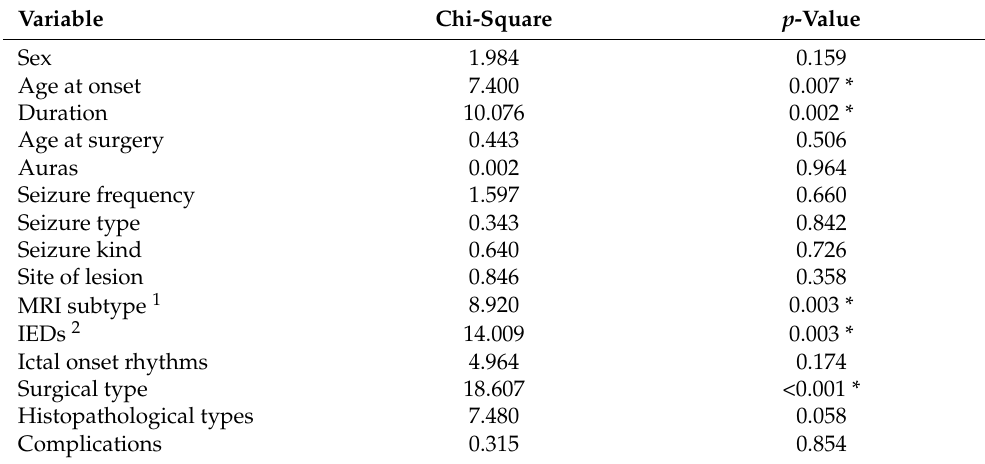
Table A2. Every univariable survival curve comparison obtained using a log-rank (Mantel–Cox) test.